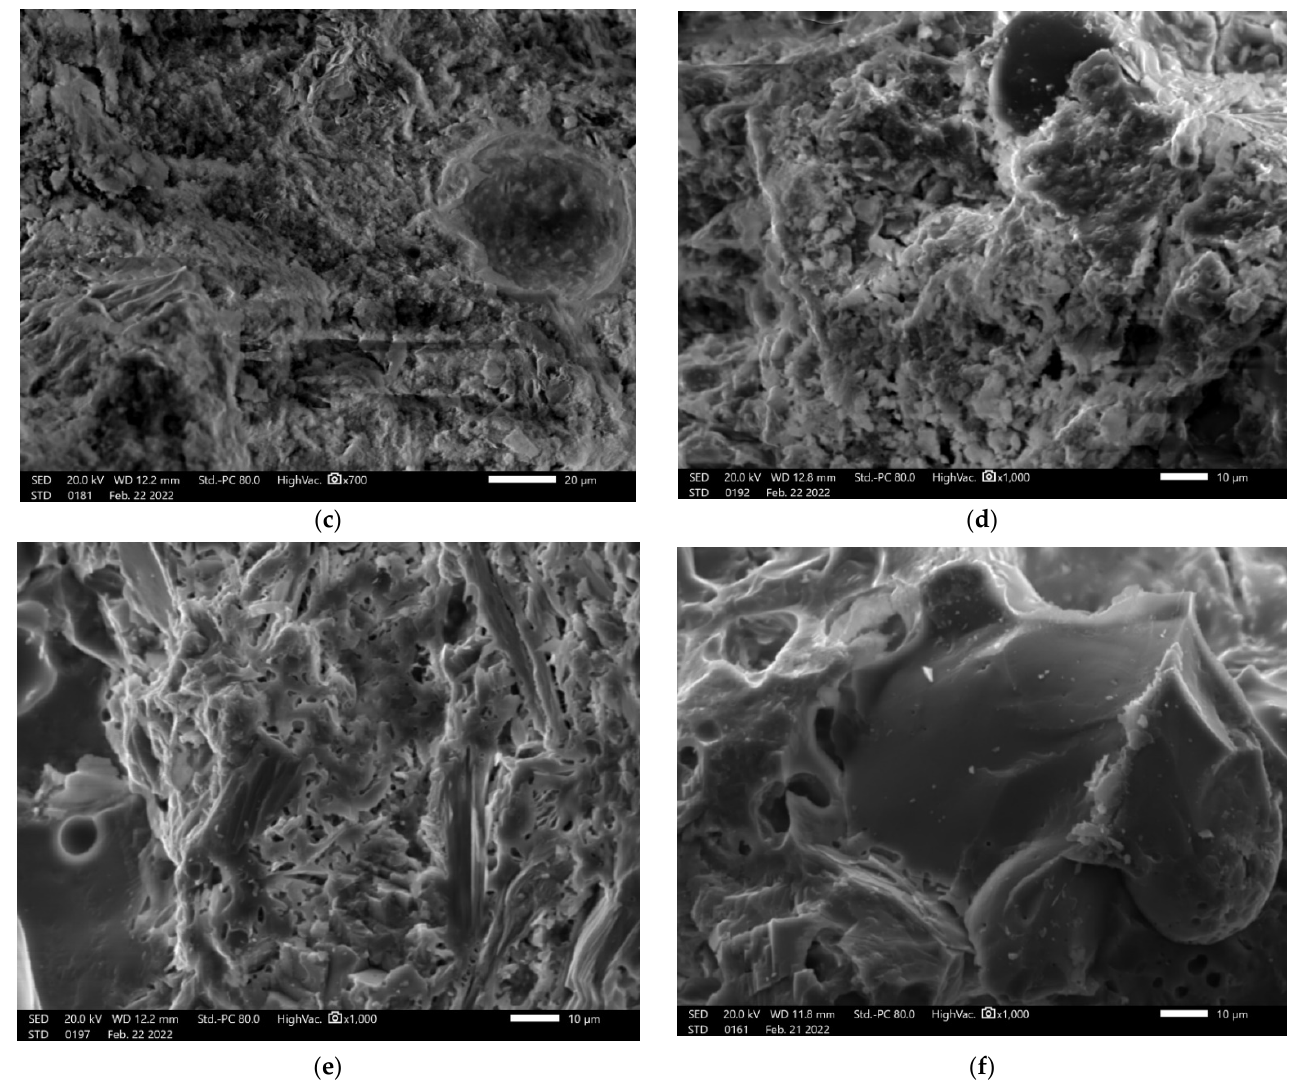
Figure 10. Microstructure of the samples Al-2 after exposure to temperature: ( a ) 20 °C Al-2; ×1000; ( b ) 200 °C Al-2; ×1000; ( c ) 400 °C Al-2; ×700; ( d ) 600 °C Al-2; ×1000; ( e ) 800 °C Al-2; ×1000; ( f ) 1000 °C Al-2; ×1000.